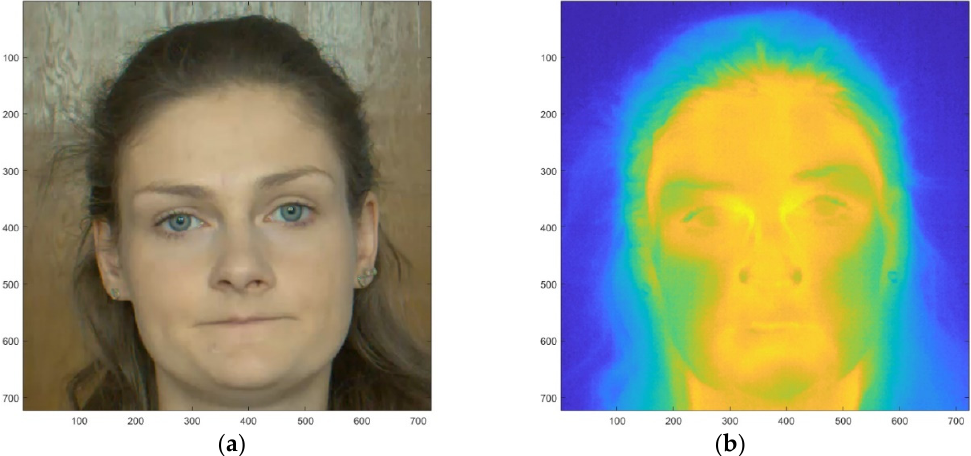
Figure 2. Corresponding areas of interest in ( a ) visible light image and ( b ) thermal image.